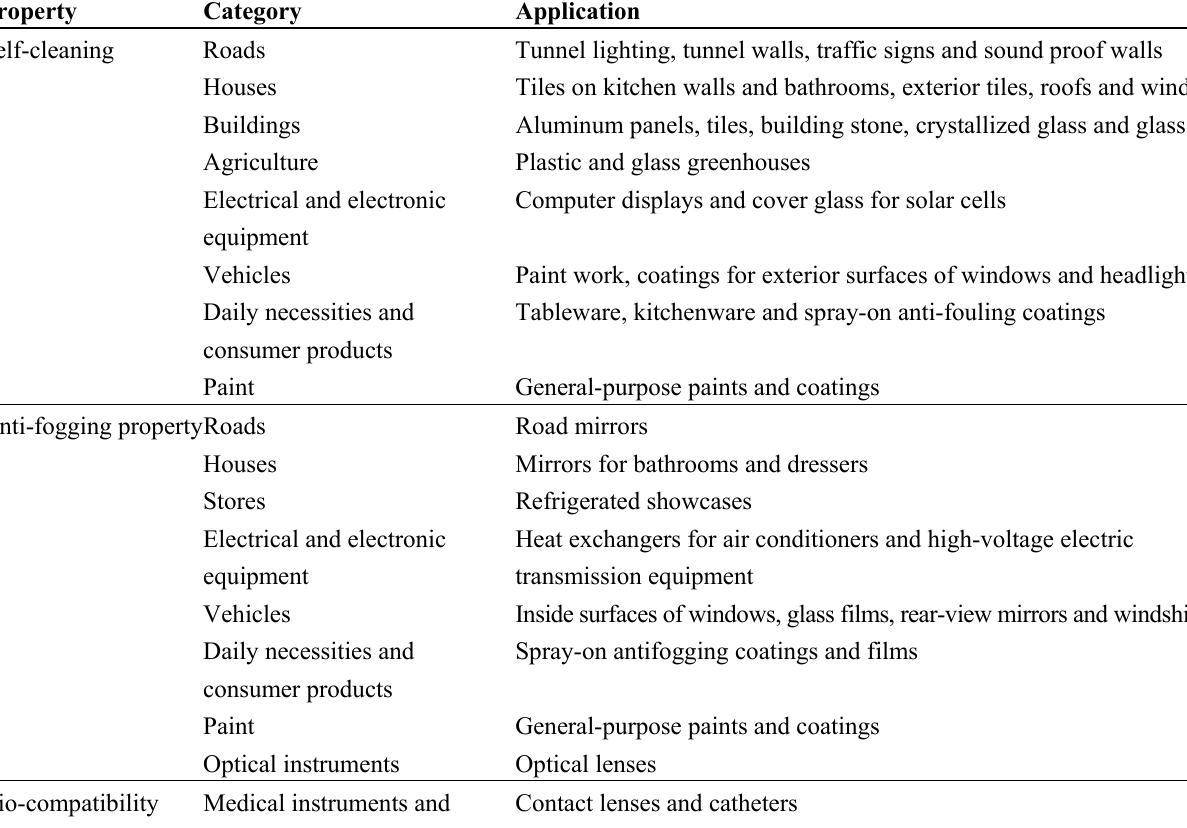
Tableware, kitchenware and spray-on anti-fouling coatings